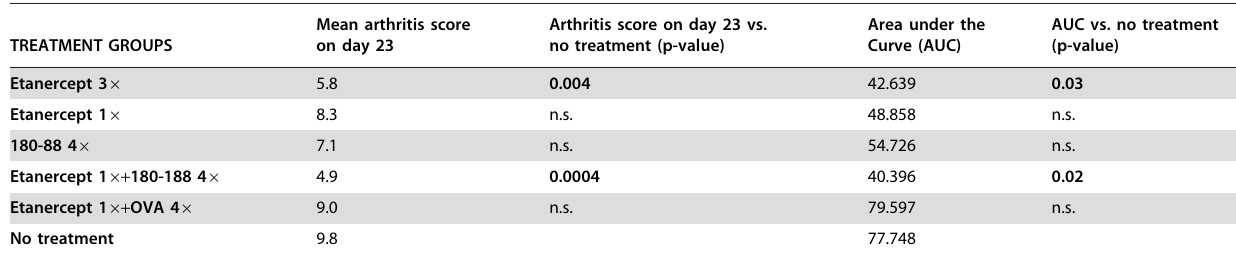
Statistical analysis was performed by the paired t-test. Different treatment groups were set out against no treatment. doi:10.1371/journal.pone.0000087.t001 .